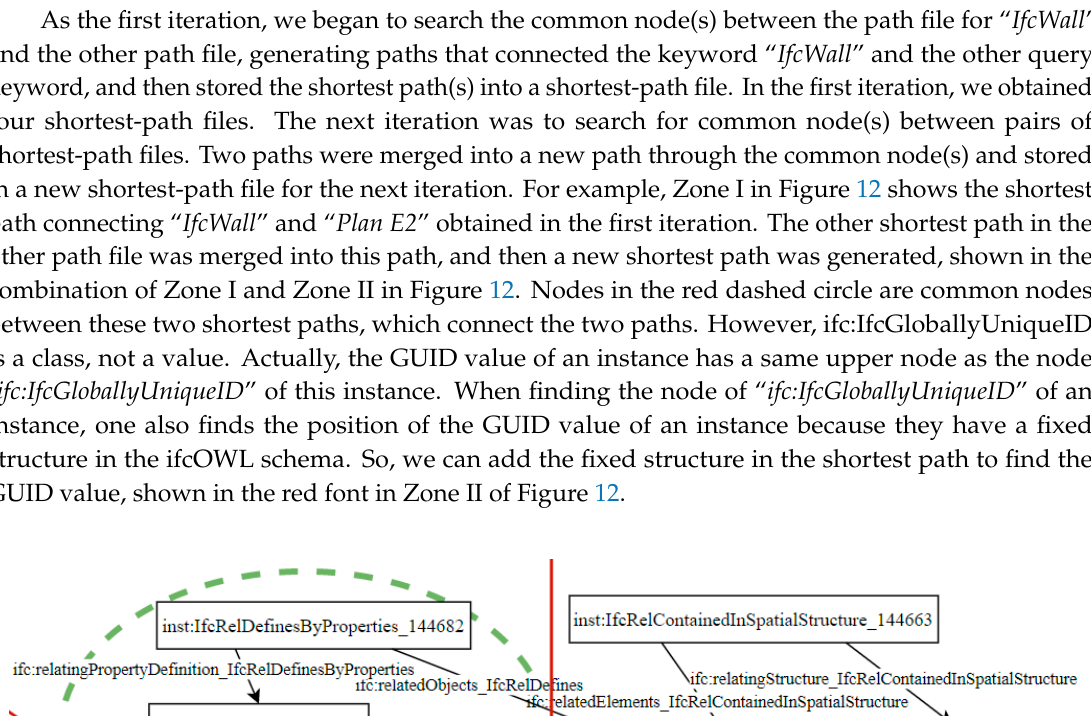
Figure 11. The codes and results of path queries based on different query keywords.